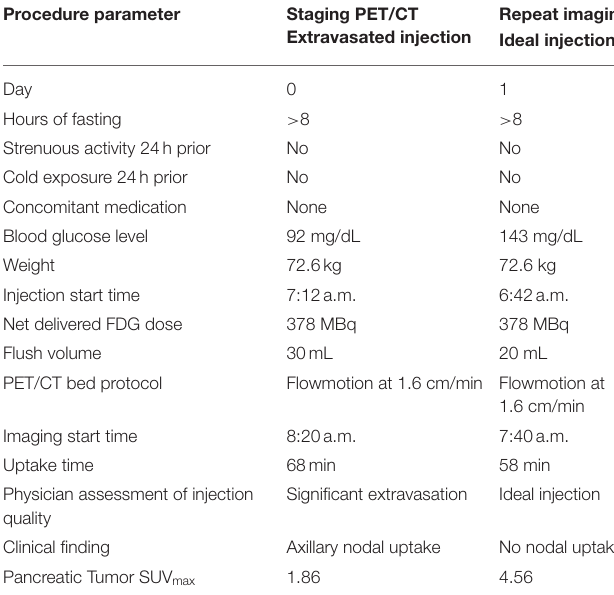
TABLE 3 | Procedure parameters for Patient A. Procedure